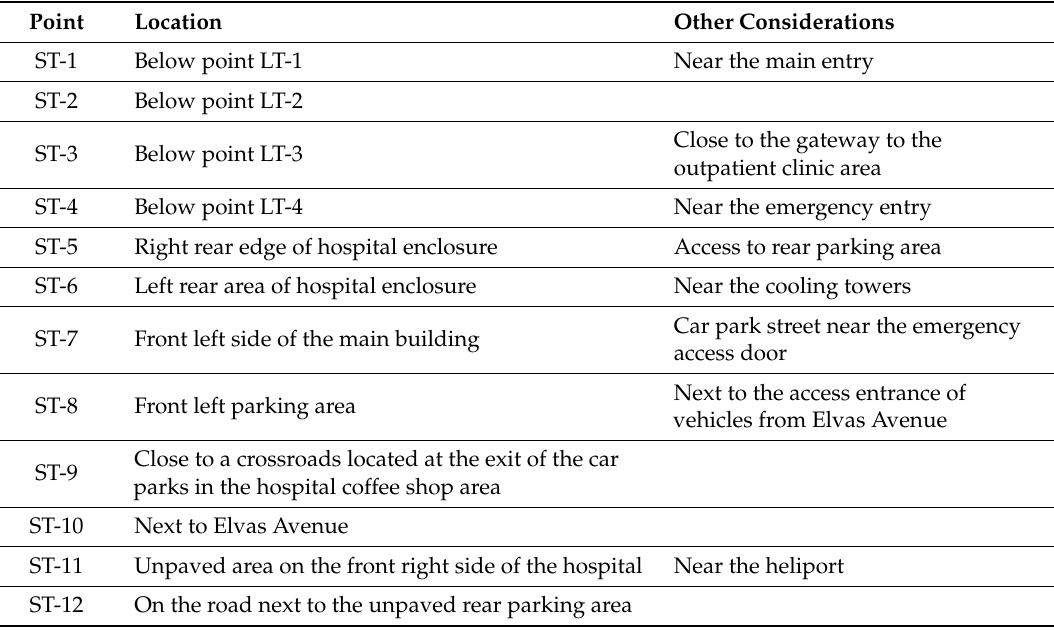
Table 2. Description of short-term (ST) measuring